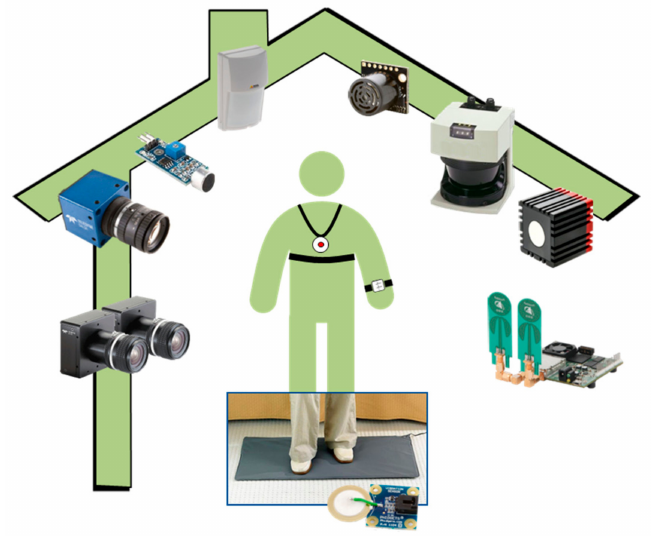
Figure 1. In health-smart homes, ambient and wearable technologies can produce a huge amount of data. From the left-hand side, the sensors are stereo-cameras, a monocular camera, microphone, pyroelectric infrared (PIR), sonar, lidar, time-of-flight camera, ultra-wideband radar, and a pressure / vibration sensor (on the